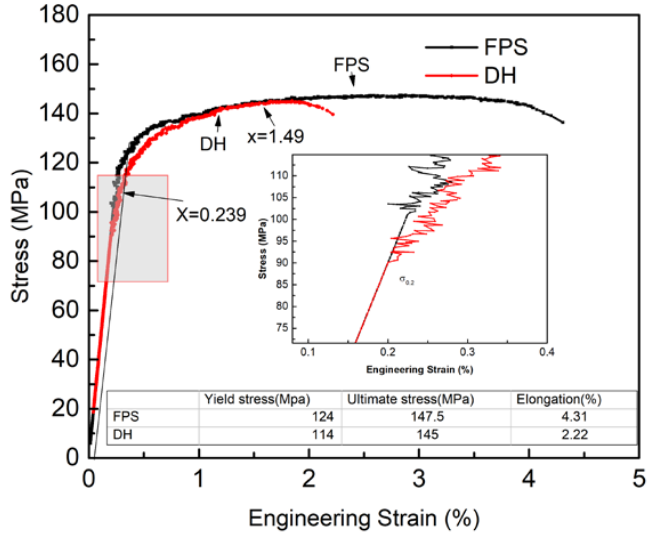
Figure 7. Engineering stress–strain curve of the DH and FPS specimens from the in situ tensile tests.